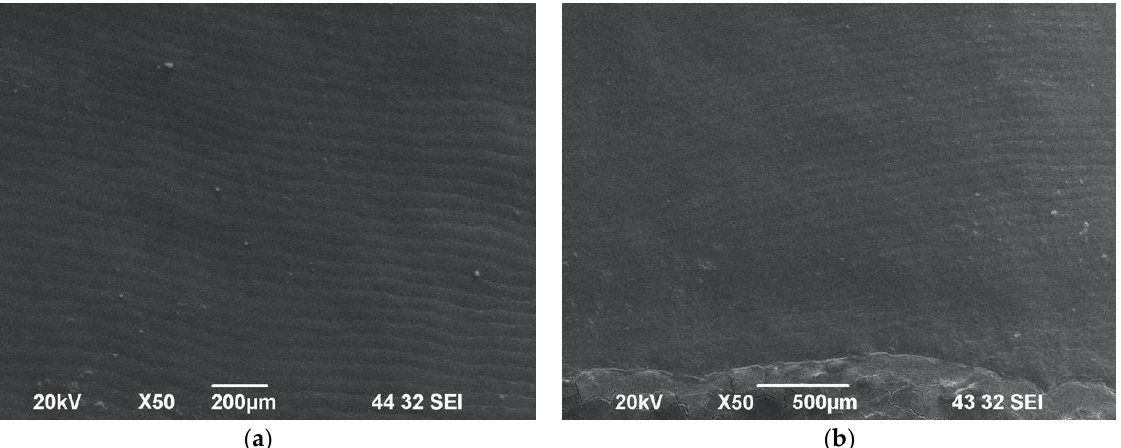
Figure 2. SEM images of enamel surfaces irradiated with 0.2 W/10 Hz/20 mJ/3 J/cm 2 under × 50 magnification. Group A ( a ) was irradiated without water spray cooling and Group B ( b ) had maximum water spray applied, with both showing an intact enamel surface morphology with striae of Retzius.